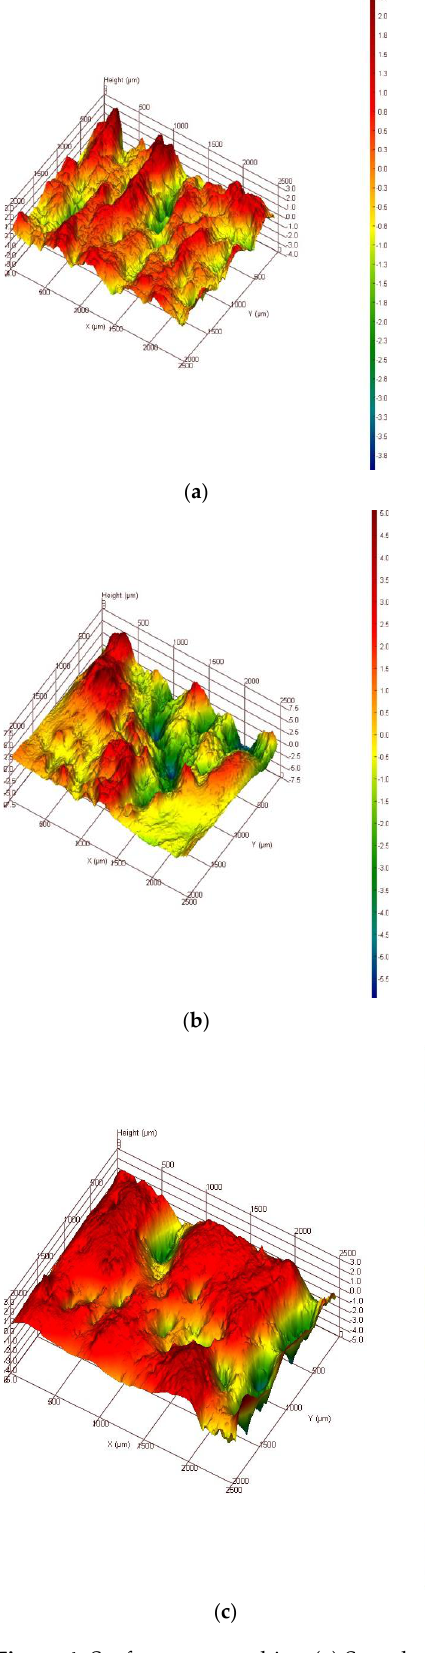
( c ) Figure 5. Surface views: ( a ) Sample 13, ( b ) Sample 15, and ( c ) Sample 6. 4. Conclusions The aim of this present research was to establish the optimum process parameters (cutting speed, focal position, frequency and duty cycle) in cutting 20 mm-thick AISI304L (DIN EN 1.4301) quality stainless-steel material on a fiber laser bench. Within the scope of this study, experiments were performed according to the experimental table created using Taguchi experimental design method, and the surface roughness values and kerf widths were measured. With the help of the Taguchi method, the optimal parameter combination results obtained for the minimum surface roughness (SR) and minimum kerf width (KW) were CS 4 FP 1 F 4 DC 1 and CS 1 FP 3 F 3 DC 3 , respectively. Additionally, according to results achieved by ANOVA, the order of importance for surface roughness was DC > CS > FP > F; for KW, it was listed as F > CS > FP > DC. Furthermore, considering both the surface roughness and kerf width, the values of contribution ratios on the multiple response functions and optimum cutting process pa- rameter level combinations were achieved by the GRA method. When all cases are exam- ined, Experiment 13 (CS 4 FP 1 F 4 DC 1 ) demonstrates the maximum multiple performance characteristics. The highest GRG value was shown with this combination; moreover, the surface roughness (SR) and kerf width (KW) values were detected as 8.31 µm and 0.33 mm, respectively. The ANOVA method of analysis was applied to calculate the participation of every parameter on multiple responses. The parameter of frequency (F) is the most important variable on the multiple responses, with an effect of 18.55%. The duty cycle (DC) and focal